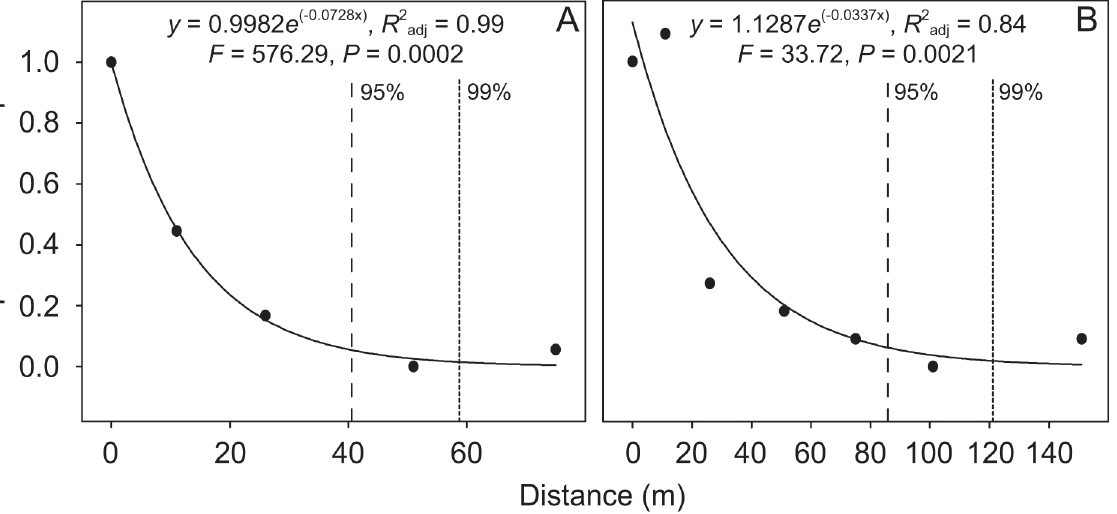
Fig 4. Proportion of recaptured Canthon rutilans cyanescens with increasing distance for estimated time periods of 48 (A) and 96 h (B). Each proportion was normalized by the number of beetles recaptured in the smallest distance category (0 – 10 m). Dashed and dotted lines represent the radius for 95 and 99% of recaptured individuals, respectively. The distance is an estimate based on the distance traveled by beetles during longer periods.